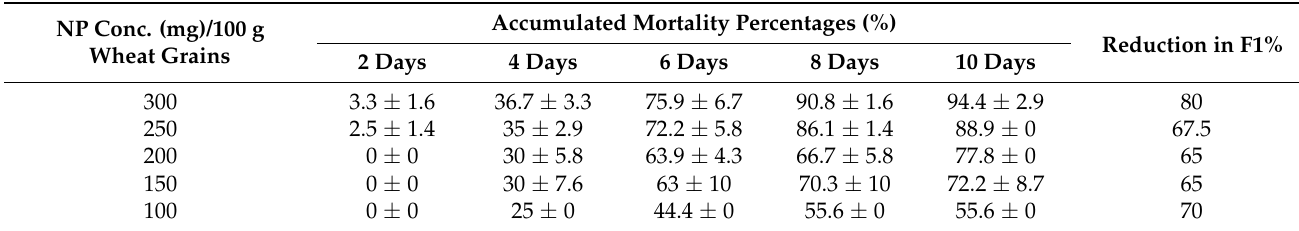
Reduction in F1%